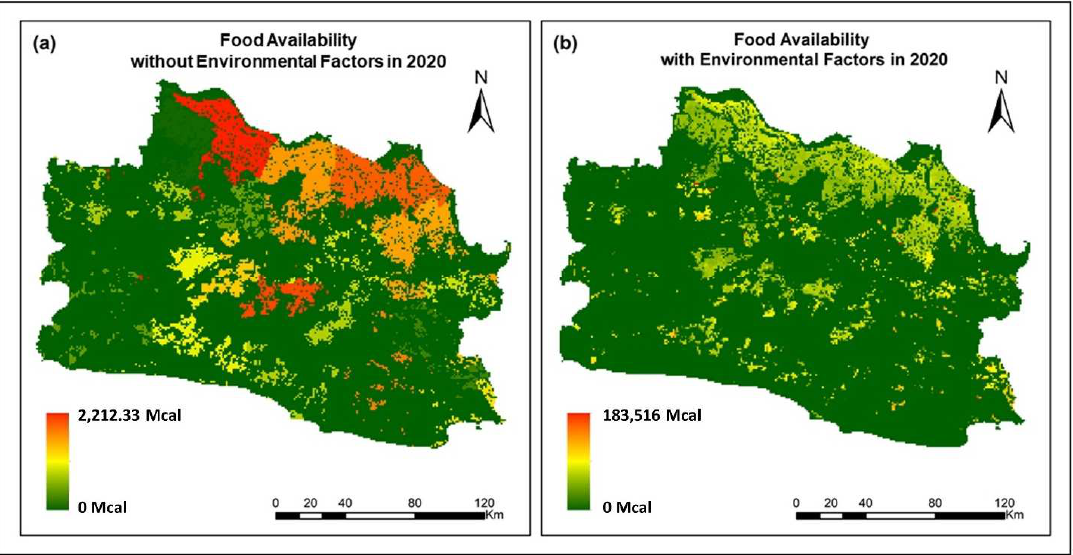
Figure 10. Food availability ( a ) without environmental factors and ( b ) with environmental factors.